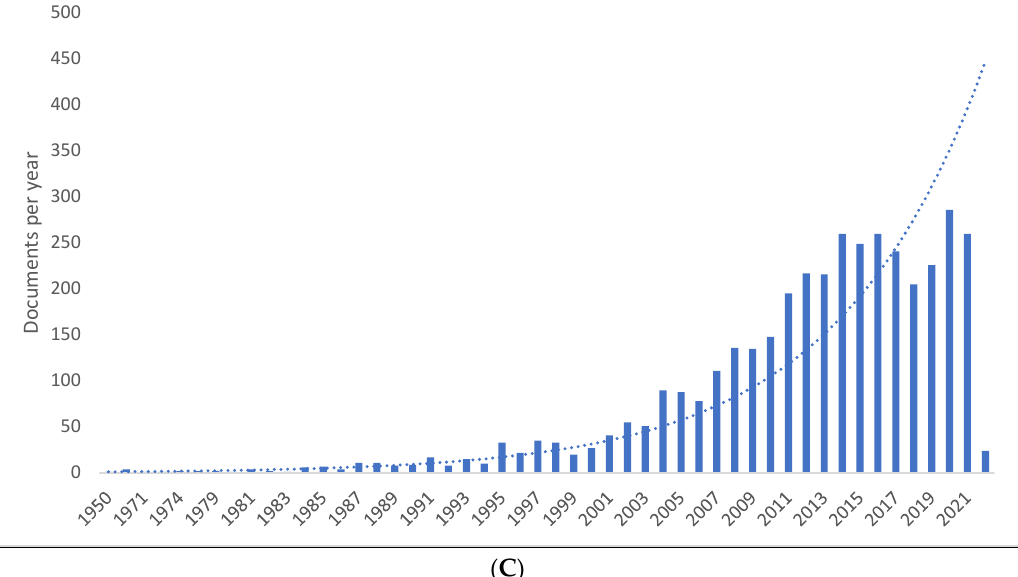
Figure 1. Pragmatic language development knowledge production size by year: ( A ) Scopus; ( B ) WOS; ( C ) Lens.